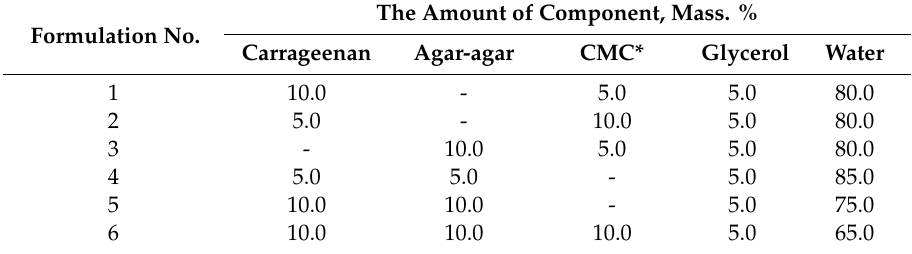
Table 1. Capsule Shell Formulations.